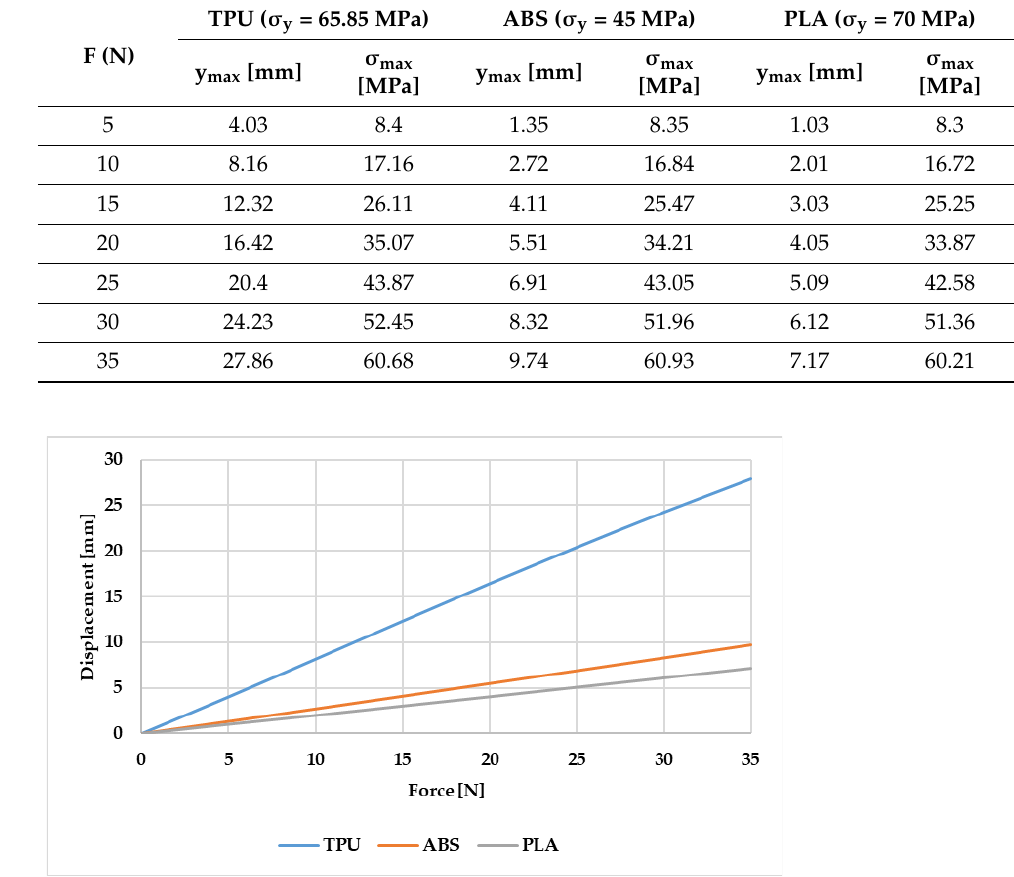
Figure 6. Obtained results for compliant mechanism with four gripping elements. 3. Physically Developed Prototype of Mechanism The mechanism was manufactured using FDM technology from PLA, ABS, and TPU (Figure 7). When using each material, the particularities of each thermoplastic used were considered. No special problems were encountered in the realization of the three variants, but noticeable differences were observed between the times necessary to print the mech- anisms. Thus, the TPU material is the most expensive in terms of time, being necessary to use it at very low speeds (10 – 20 mm/s-Figure 8), compared to PLA/ABS (30 – 35 mm/s), the results being similar in terms of aesthetics.